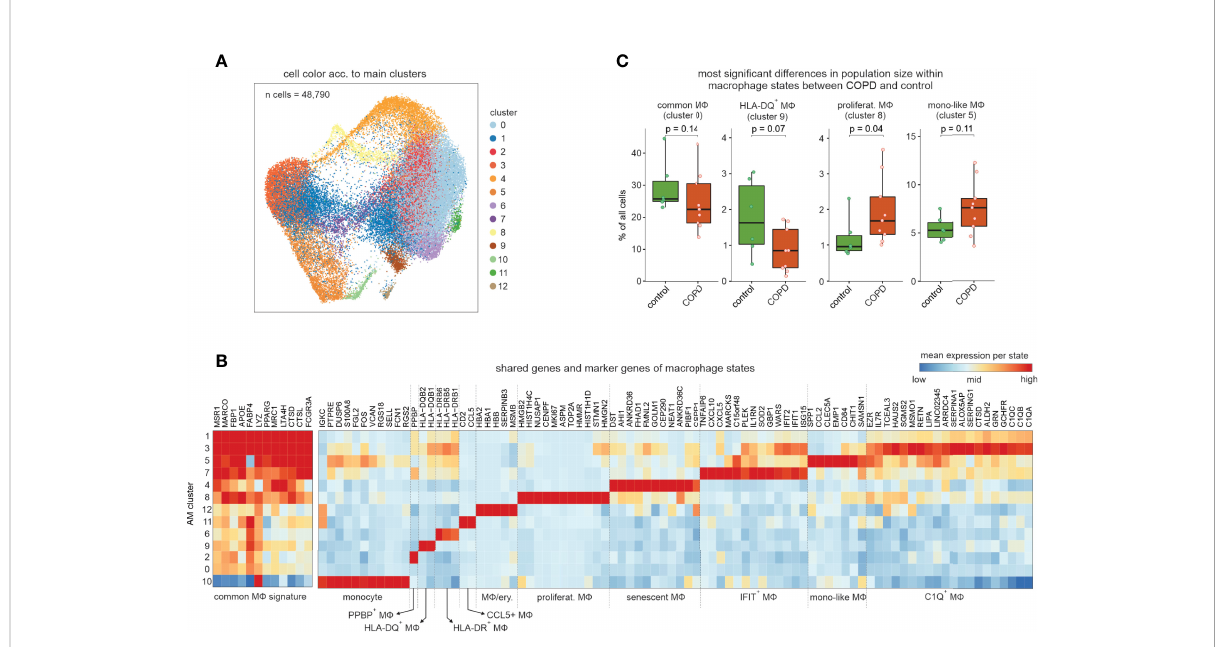
FIGURE 2 Exploration of the macrophage and monocyte cell types and states in human BALF. (A) UMAP representation and clustering of cells annotated as monocytes or macrophages by the four-step annotation approach (according to Figure 1). (B) Heatmap of marker genes per macrophage/ monocyte cluster (referred to as ‘ macrophage states ’ ; according to Figure 2A). The marker gene expression per macrophage state is represented as a z-transformed value across all macrophage states. On the left side of the heatmap, conserved macrophage markers are depicted. Columns and rows of the heatmap are sorted by hierarchical clustering. (C) Box visualization plot (with marked median values) of most signi fi cant differences in population sizes within the identi fi ed macrophage states between COPD and control (error bars indicating the standard deviation; statistics based on Wilcoxon rank sum test). n, number; M Ф ,